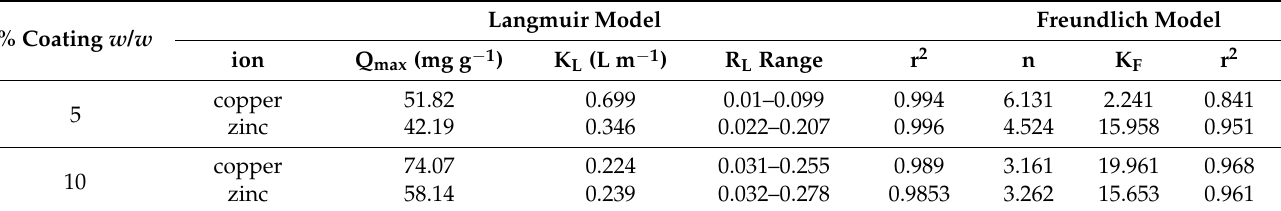
Table 2. Isotherm constants for the adsorption of Cu 2+ and Zn 2+ . Langmuir Model